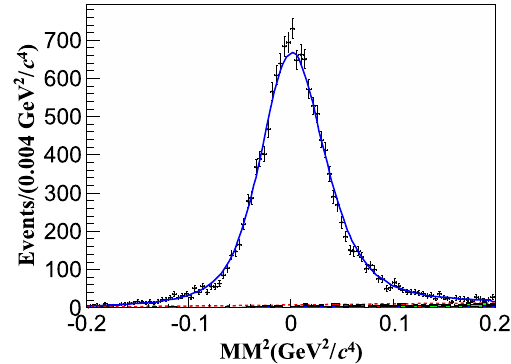
Fig. 2 Fit to the MM 2 distribution of the D + s → μ + ν μ candidates. Dotswitherrorbarsarethepseudo-data.Bluesolidcurveisthefitresult. Red dotted curve is the fitted background. Green and red cross-hatched histograms are the BKGI component, and blue histogram is the BKGII component,